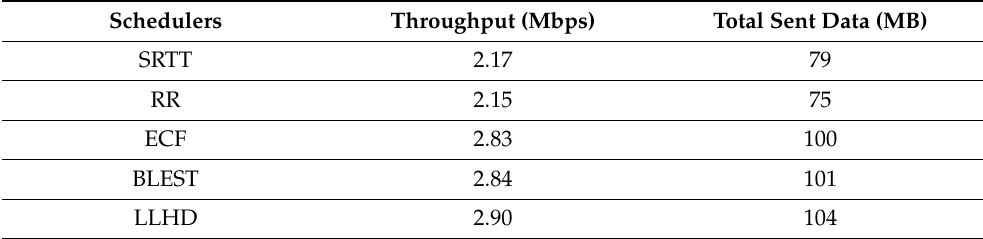
Table 1. Throughput and total sent data for the considered schedulers.